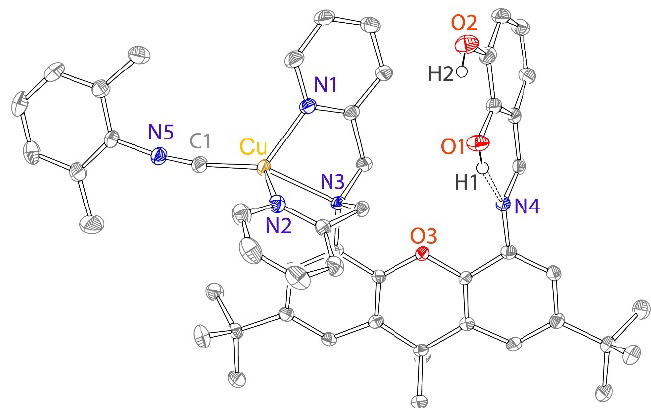
Figure 1. The structure of 2 (PF 6 ) with 50% probability ellipsoids. PF 6 counterion, hydrogen atoms, and co-crystallized solvent (ether) were omitted for clarity.